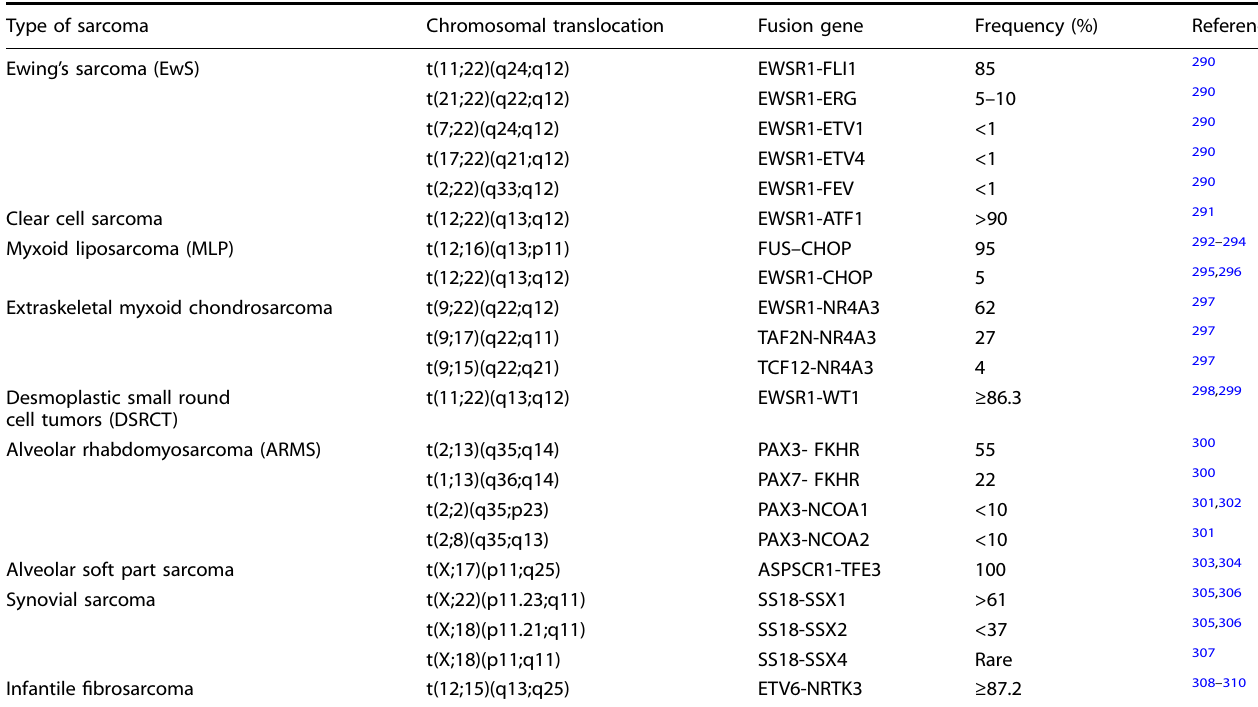
Table 1. Chromosomal changes observed in a selection of sarcomas with simple